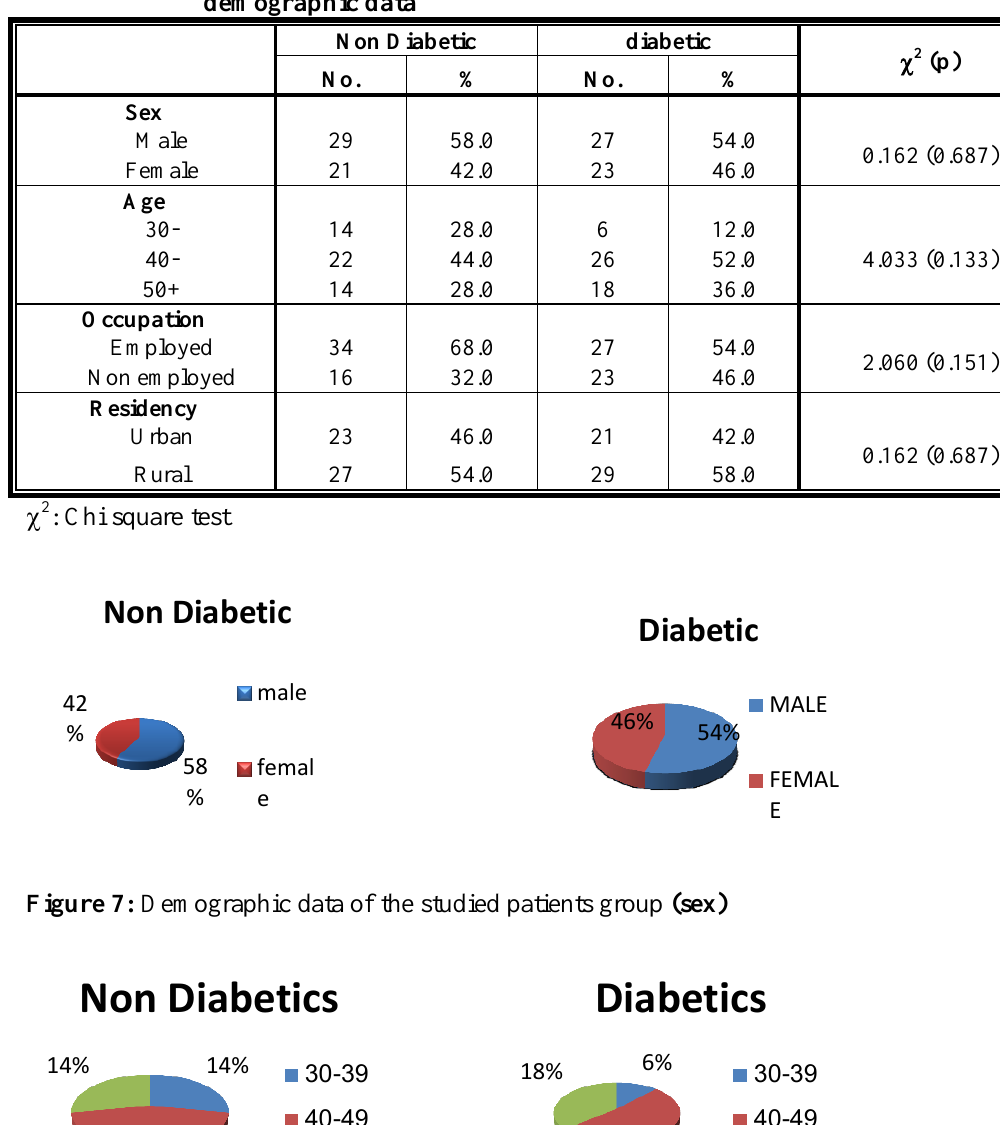
Comparison between diabetic and non-diabetic cases according to demographic data